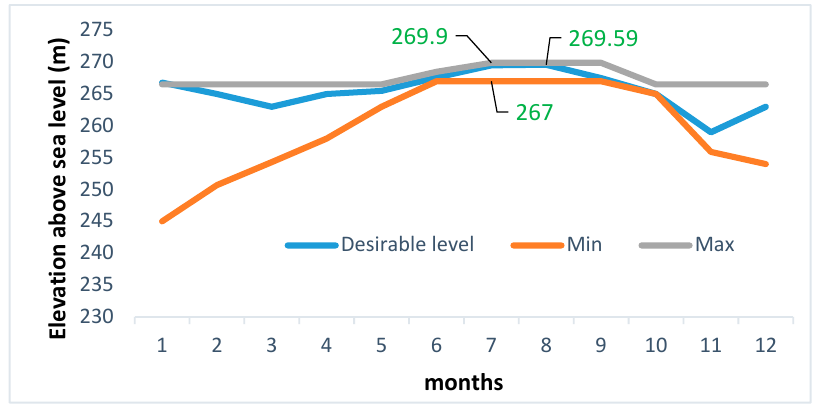
Figure 9. State of HPP Jablanica reservoir [46].